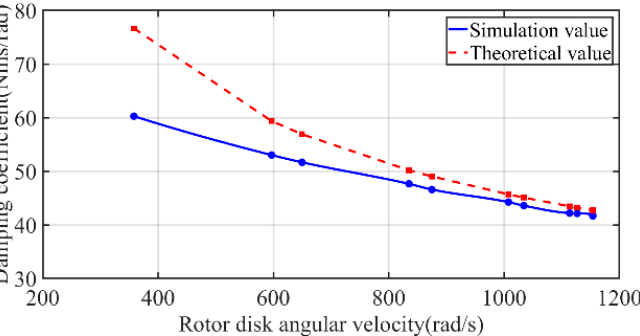
Figure 18. Distribution of damping coefficient with angular velocity of rotor disk.